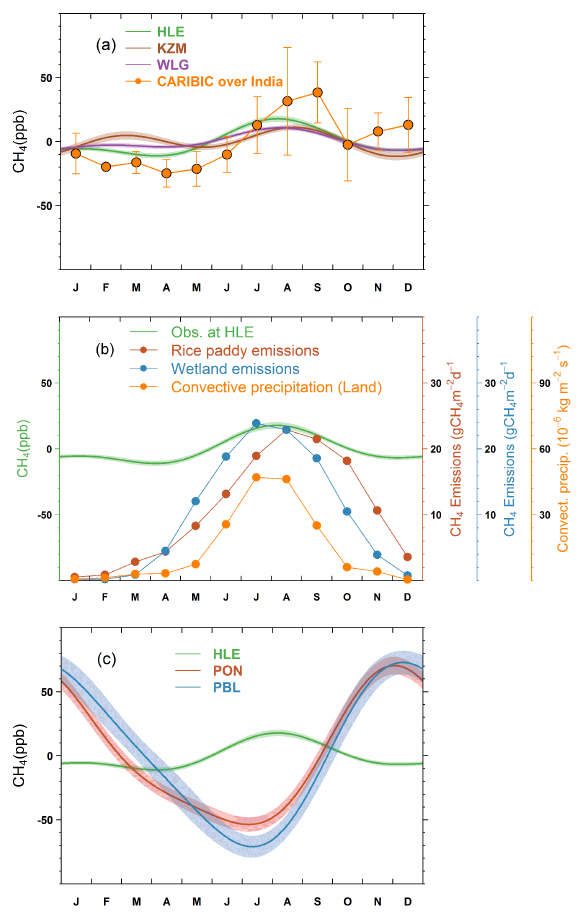
Figure 5. (a) The mean CH 4 seasonal cycles observed at HLE, KZM and WLG. The mean CH 4 seasonal cycle derived from air- craft flask measurements by the CARIBIC project is also presented. The CARIBIC flask measurements in the upper troposphere (200– 300hPa) during 2005–2012 are averaged over the Indian subcon- tinent (10–35 ◦ N, 60–100 ◦ E) by month to generate the mean sea- sonal cycle. The error bars indicate 1 standard deviation of CH 4 flask measurements within the month. (b) The seasonal variations of CH 4 emissions from rice paddies and wetlands over the Indian subcontinent. The CH 4 emissions from rice paddies are extracted from a global emission map for the year 2010 (EDGAR v4.2, 2011), imposed by the seasonal variation on the basis of Matthews et al. (1991). The CH 4 emissions from wetlands are extracted from outputs of a global vegetation model (BIOME4-TG, Kaplan et al., 2006). The seasonal variation of deep convection over the Indian subcontinent is also presented, indicated by convective precipitation obtained from an LMDZ simulation nudged with ECMWF reanal- ysis (Hauglustaine et al., 2004). The CH 4 emissions and convective precipitation are averaged over the domain 10–35 ◦ N, 70–90 ◦ E to give a regional mean estimate. (c) The mean CH 4 seasonal cycles observed at HLE, PON and PBL. For each station, the mean sea- sonal cycle is derived from the harmonics of the smoothed fitting curve in Fig. 4. Shaded area indicates the uncertainty of the mean seasonal cycle calculated from 1 SD of 1000 bootstrap